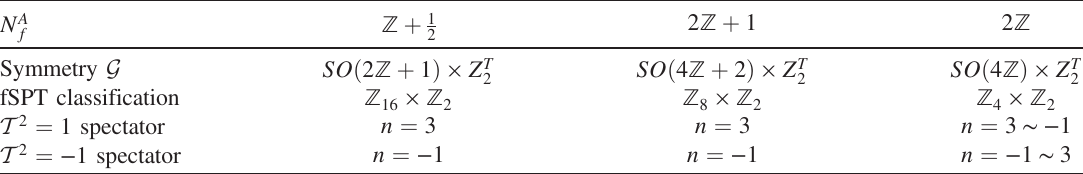
TABLE I. A summary for SU ð 2 Þ þ N A theory with general N A . The global symmetry associated with the system f f is SO ð 2 N A . The last two rows show the topological index for the Þ × Z T 2 . The SPT classification depends on the N A f f m > 0 phase for both choices of the spectator field. In all cases, η ¼ 0 , so we do not include it in the table. N A